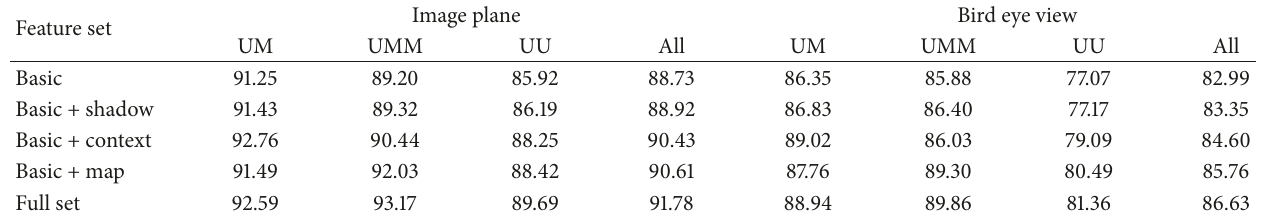
Table 5: Performance comparison of unary potentials trained with different combination of features.